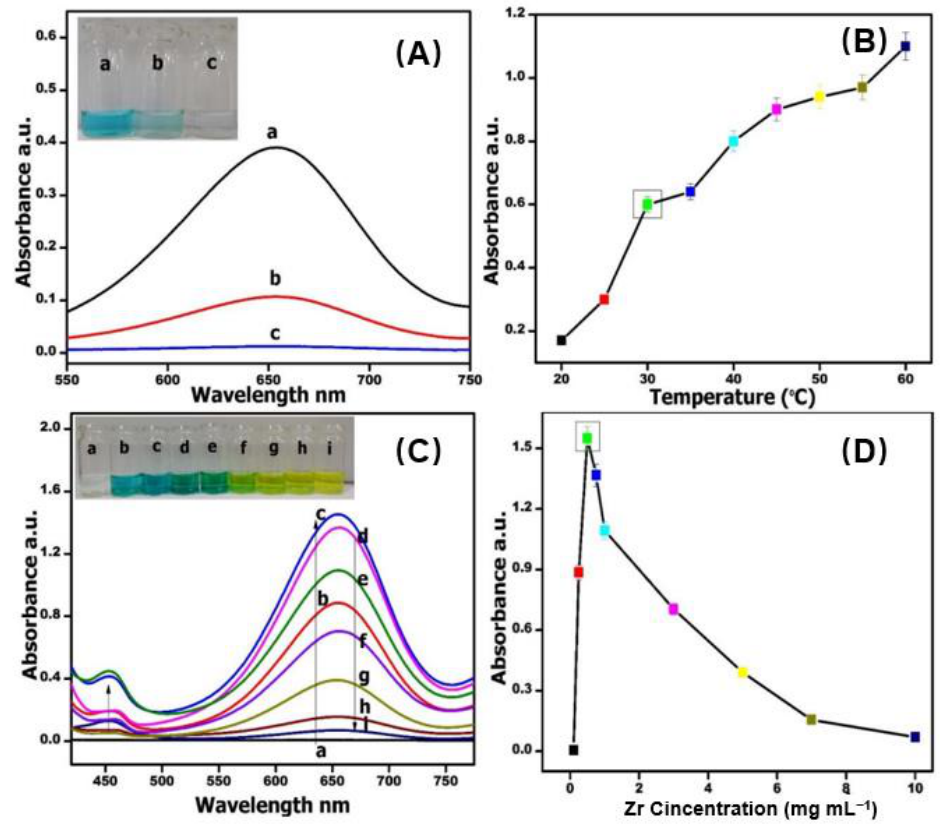
Figure 9. Optimization of different parameters on TMB oxidation. Investigation of ( A ) the effect of different mediums: (a) DI water, (b) PBS (pH-7.4), (c) NaAc (pH-5.5), ( B ) effect of the increase in temperatures (20 °C, 25 °C, 30 °C, 35 °C, 40 °C, 4 5°C, 50 °C, 55 °C, 60 °C) ( C ) effect of increasing concentrations of Zr from (a) 0 mg. mL −1 (b) 0.1 mg. mL −1 (c) 0.25 mg. mL −1 (d) 0.5 mg. mL −1 (e) 0.75